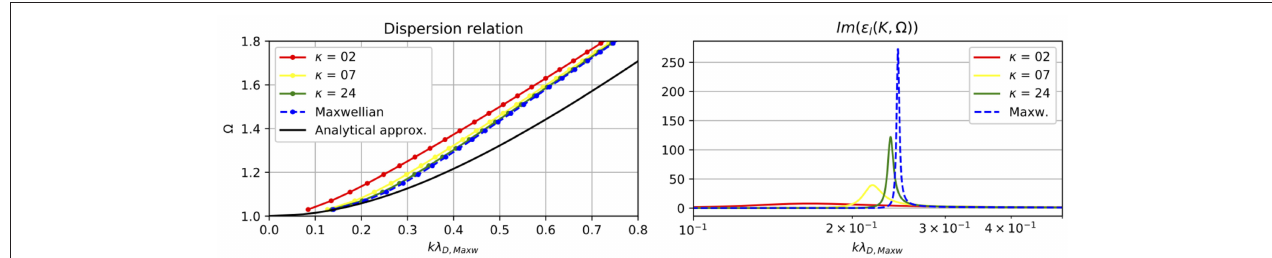
values ( κ 2,7 and 24) and the Maxwellien evdf ( κ − =